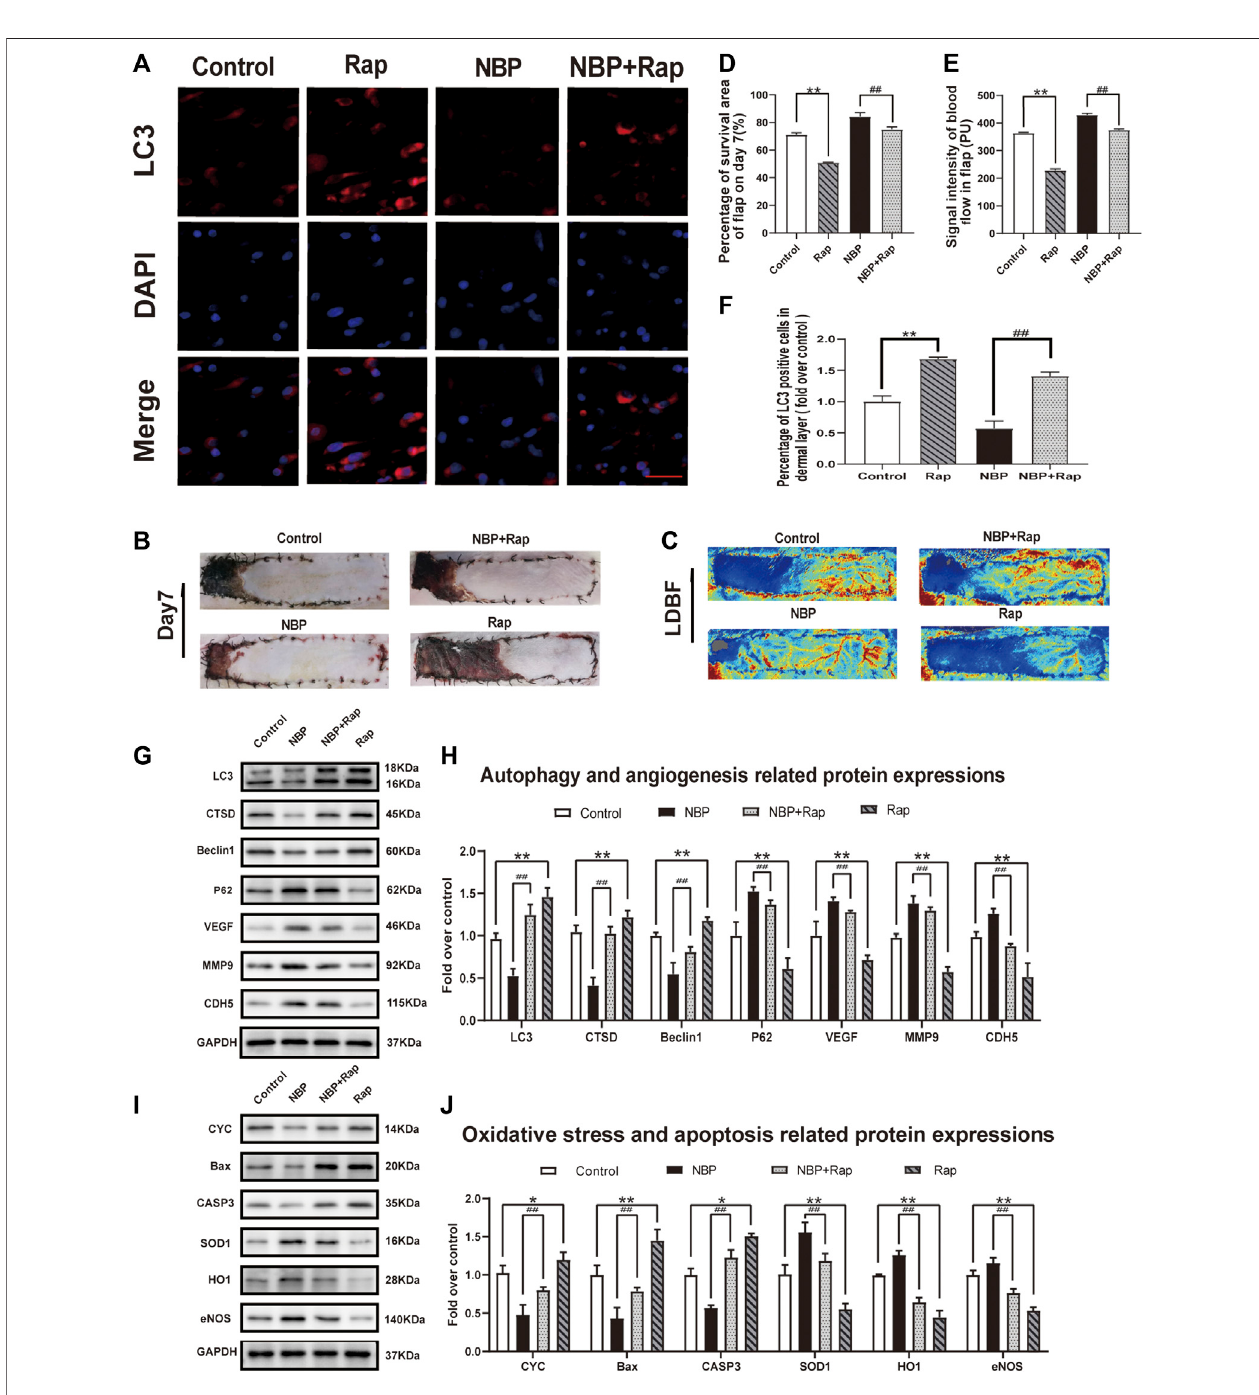
FIGURE6| RapamycinreverseseffectsofNBPonangiogenesis,oxidativestress,andapoptosisinmultiterritoryperforator fl ap. (A) Autophagosomes(LC3,red)in cells in thecontrol,NBP,NBP +rapamycin, and rapamycin groups. Nuclei are counterstained withDAPI (blue) (scale bar, 20 μ m). (B) Digital images ofthecontrol, NBP, NBP+rapamycin,andrapamycingroupsonPOD7. (C) LDBFineachgrouponPOD7. (D) PercentageofsurvivalareaonPOD7. (E) Percentageofthesignalintensityof blood fl ow within the fl ap in each group. (F) LC3 positive cells in each group. (G) Autophagy-related protein expression (LC3, CTSD, Beclin1, and SQSTM1/p62) and angiogenesis-related proteins (VEGF, MMP9, and CDH5). (H) Optical density of LC3, CTSD, Beclin1, SQSTM1/p62, VEGF, MMP9, and CDH5 in each group. (L) Apoptosis-related protein expression (CYC, Bax, and CASP3) and oxidative stress-related protein expression (SOD1, HO1, and eNOS) in each group. (M) Optical density ofCYC, Bax, CASP3, SOD1, HO1, and eNOS expressions in each group. Gels were run under similar experimental conditions and edited only for clarity. Values are shown as mean ± SEM, n (cid:1) 6 per group. * p < 0.05 and ** p < 0.01 vs. control group; # p < 0.05 and ## p < 0.01 vs. NBP group.